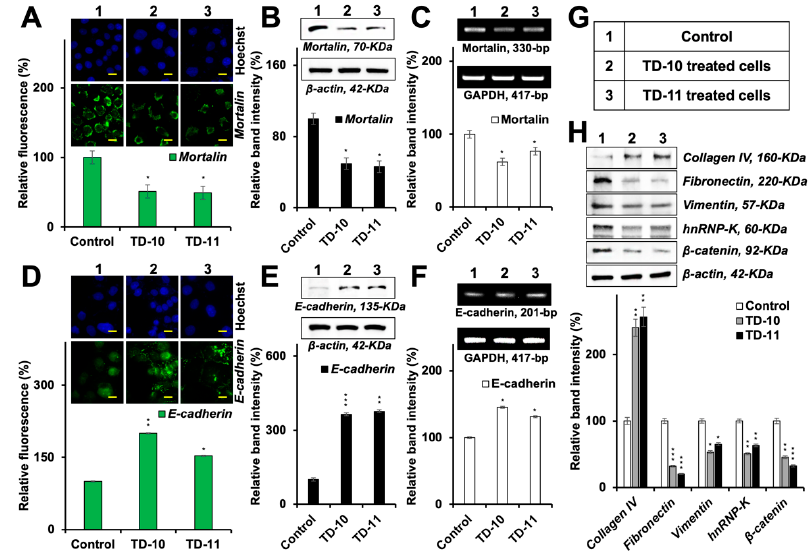
Figure 8. Downregulation of mortalin in response to the treatment with TD-10 and TD-11 in Panc-1 cells. Immunostaining ( A ) and Western blotting ( B ) showed decrease in mortalin protein. ( C ) RT-PCR showed downregulation of expression of mortalin at the transcription level. Immunostaining ( D ) and Western blotting ( E ) showed an increase in E-cadherin protein. ( F ) RT-PCR showed upregulation of E-cadherin at the transcription level. ( G ) List of treatments in A–F is shown. ( H ) Western blotting and quantitation showed upregulation of collagen IV and downregulation of other EMT proteins in cells treated with the TEG derivatives. Scale 20 µm. Statistical significance was defined as p -values (*) where * < 0.05, ** < 0.01 and *** < 0.001 represent significant, very significant and highly significant, respectively.